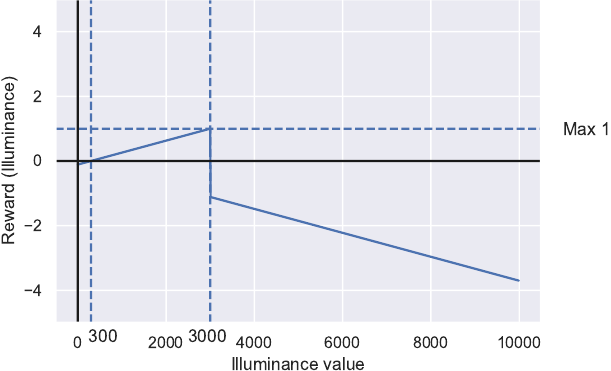
Figure 4. Reward function based on illuminance (Workplace illuminance).